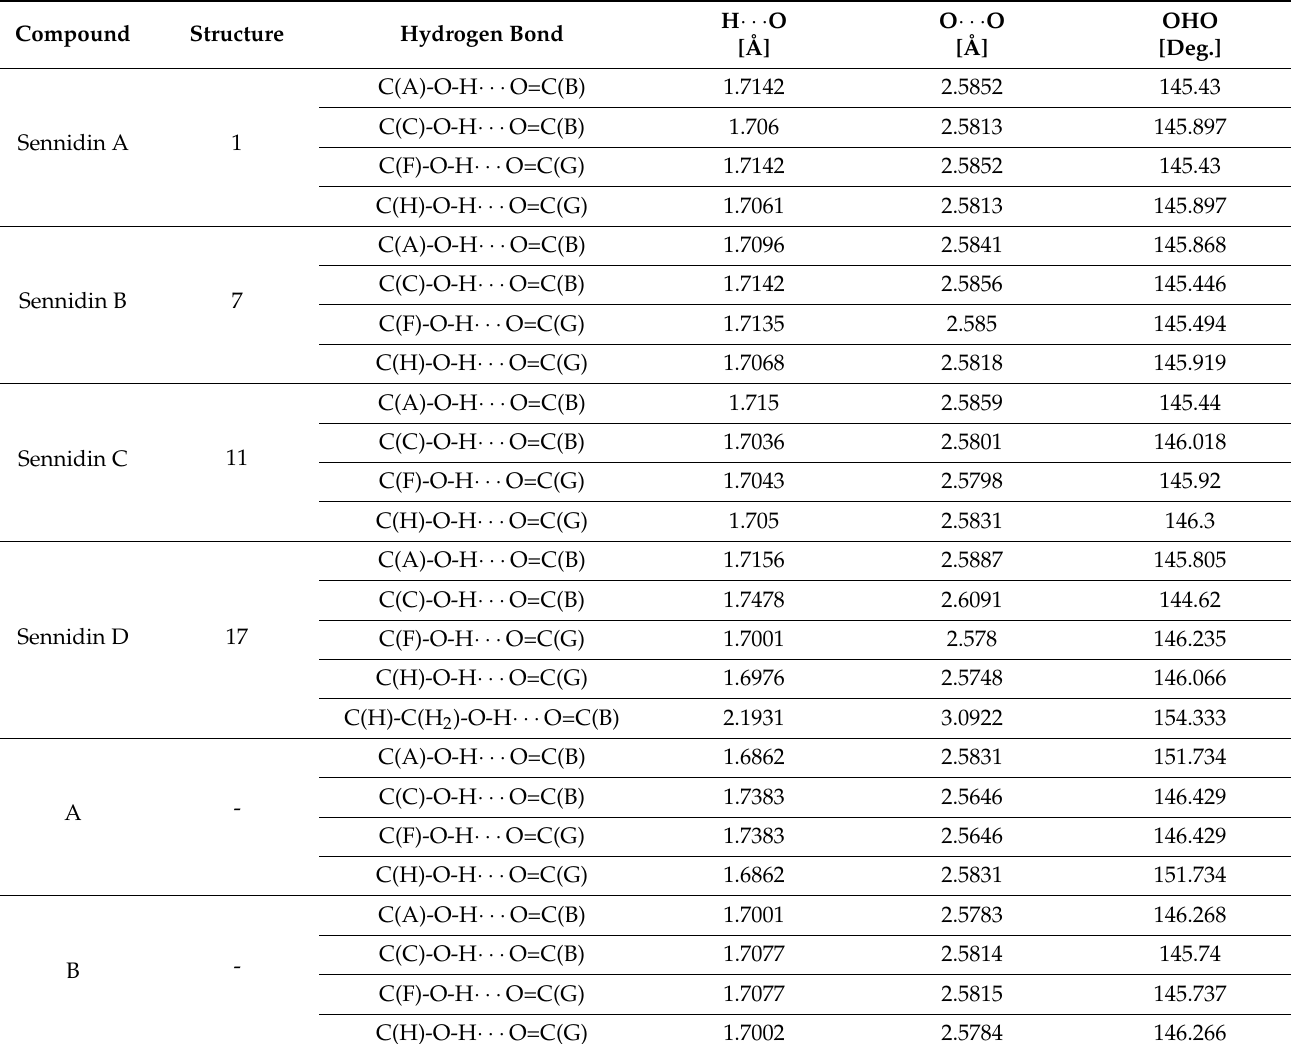
Table 2. Hydrogen bonds in sennidin A–D lowest energy structures, crystal “A” and calculated “B” double-anthrone moieties, σ = 0.0001 [Å], σ = 0.001 [deg.].